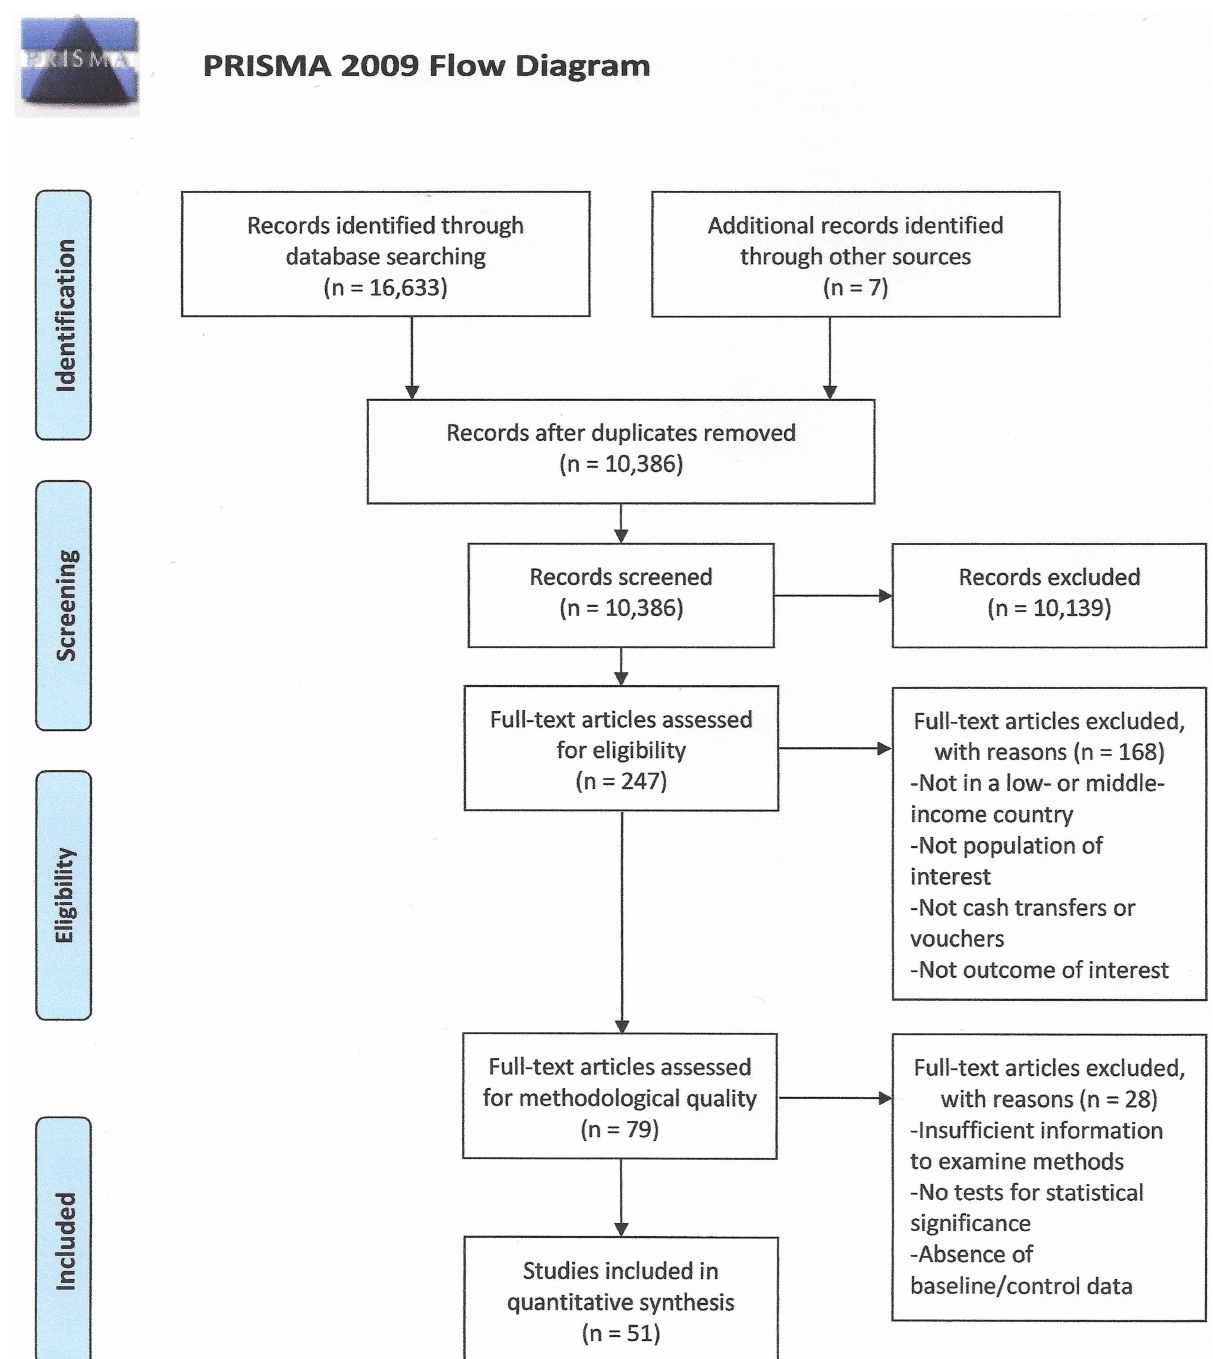
Fig 1. Systematic review flowchart. From : Moher D, LiberatiA, Tetzlaff J, Altman DG, The PRISMA Group (2009). P referred R eporting I tems for S ystematic Reviewsand M eta- A nalyses: The PRISMA Statement. PLoS Med 6(7): e1000097. doi:10.1371/journal.pmed1000097. For more information, visit